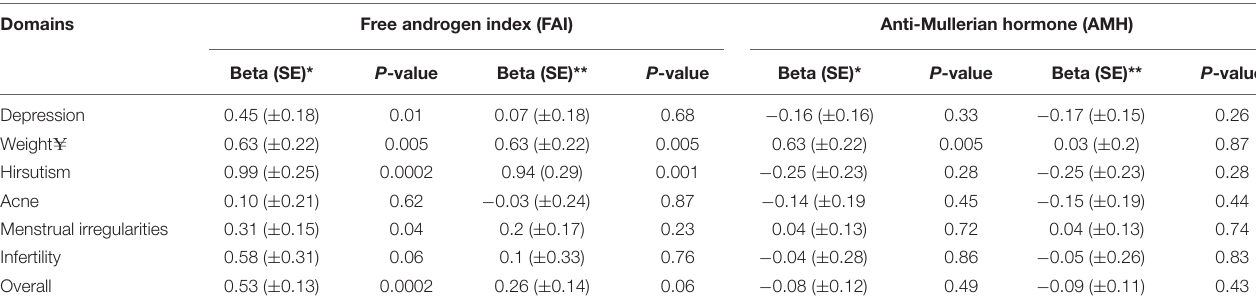
TABLE 3 | Regression analysis for the effect of FAI and AMH on the domains of the MPCOSQ. Domains Free androgen index (FAI)